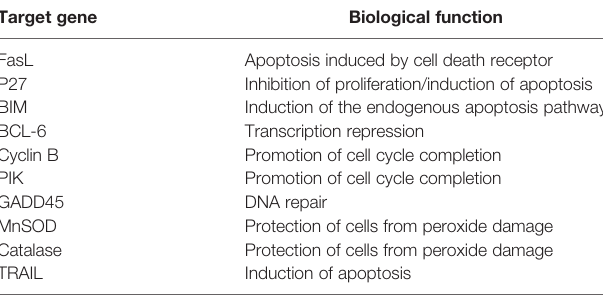
TABLE 1 | Downstream target genes of Forkhead box O proteins in tumor